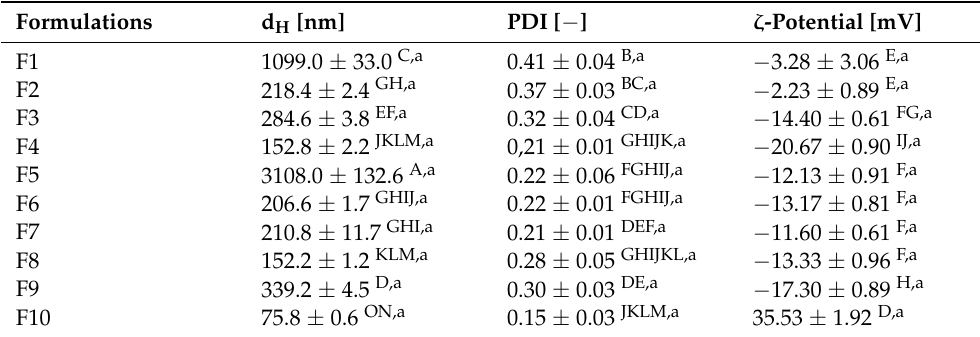
Table 3. Hydrodynamic diameter d H , polydispersity index PDI, and ζ -potential of the tested delivery systems for essential